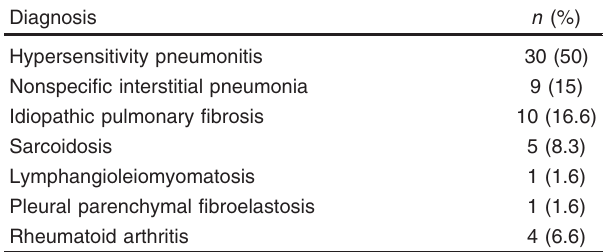
Table 2 The diagnosis of studied patients